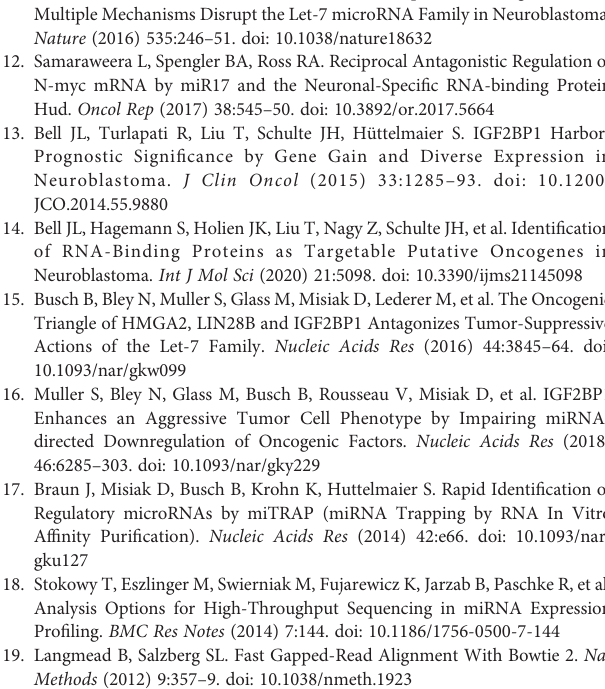
Supplementary Figure 1 | MiRNA enrichment in miTRAP studies is independent of miRNA abundance. The enrichment of miRNAs with the MYCN-3 ’ UTR (compared to MS2 controls) was plotted over the abundance of respective miRNAs ininputsamples, asdeterminedbymiRNAseq.NocorrelationofmiRNAabundance and enrichment was observed by Pearson correlation in indicated cell lines. BE(2)- C: R P = 0.001072; p = 0.9688 and KNS42: R P = 0.002382; p = 0.9306. Supplementary Figure 2 | Expression of IGF2BP1 and ELAVL4 in neuroblastoma. The expression of IGF2BP1 (left panel) and ELAVL4 (right panel) in MNA (92 samples) and nMNA (401 samples) neuroblastoma tumors were analyzed in a public available mRNA-seq data set on R2 database (https://r2.amc.nl; SEQC dataset, GEO ID: